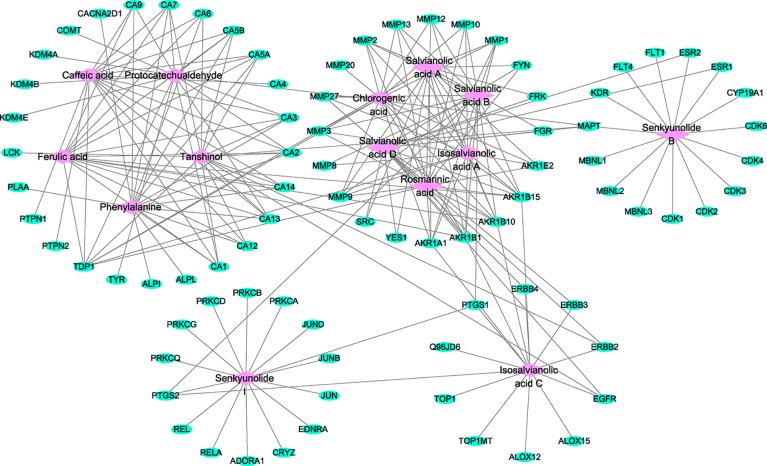
Component–target network for the identified components of GXNT on thrombus. The component–target network was constructed by linking the 14 identified components and their potential targets. The green nodes represent the potential targets and the pink nodes represent the identified components. Edges represent the interactions between the compounds and the targets in the network.